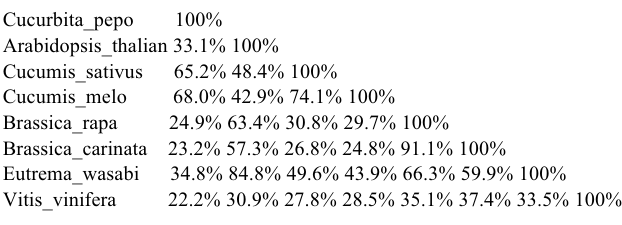
Fig. 4: Homology matrix of Cucurbita pepo Partial PR1 cds and seven other